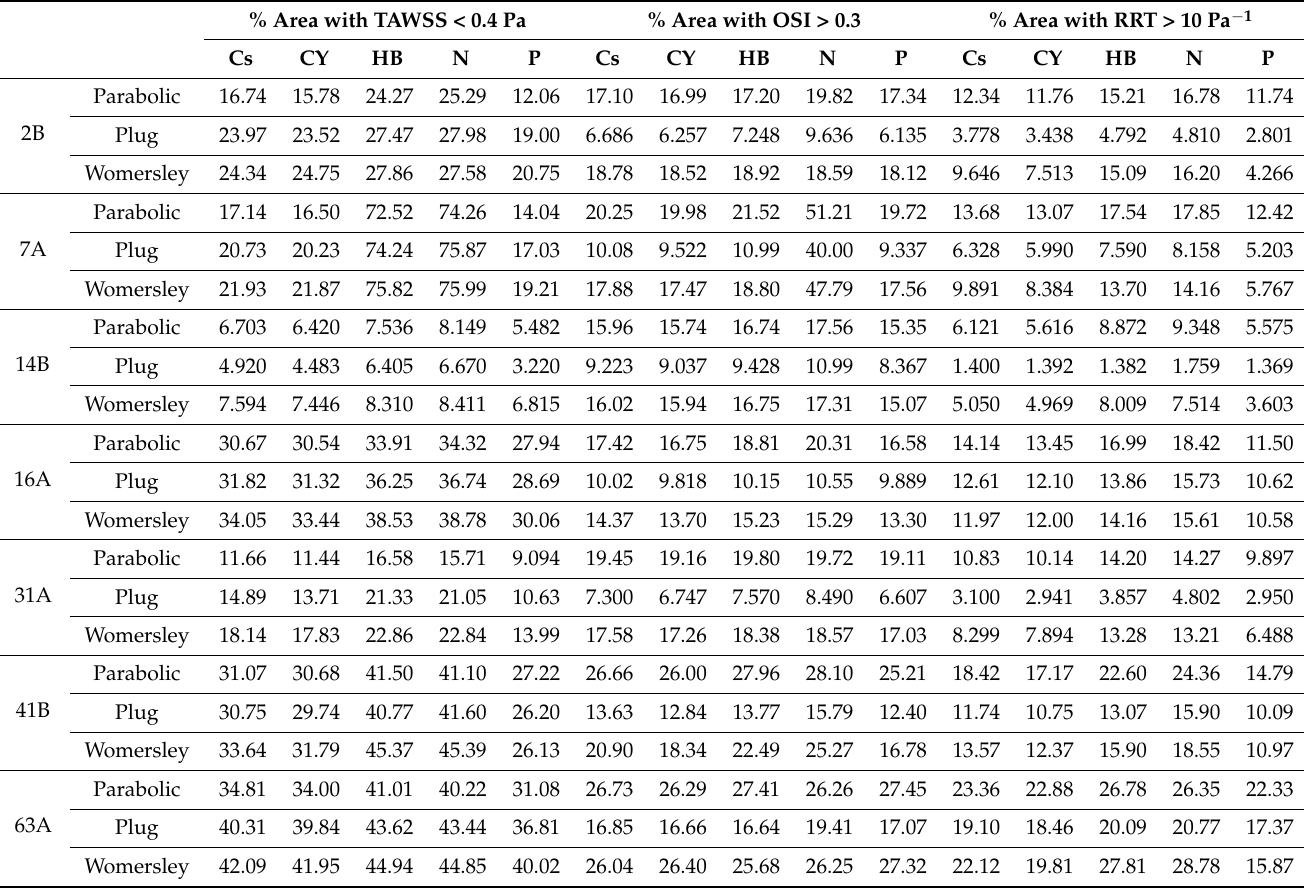
Table 6. Percentage areas with thrombus-prone